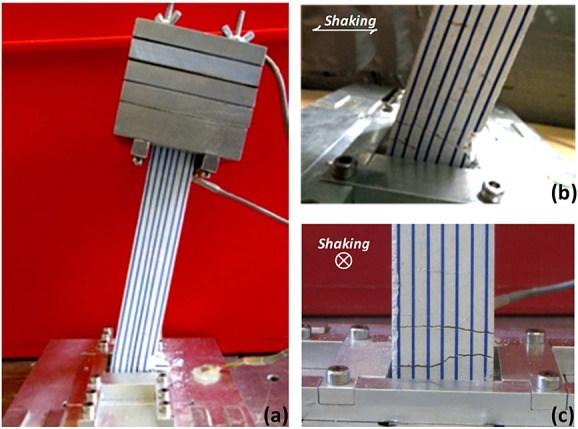
Photos of the conventional pier after Test 6 indicating the damage induced by shaking with Earthquake Scenario B followed by one additional very strong motion (the Takatori record): (a) view of the entire pier model (b) in-plane and (c) out-of-plane views of the column–foundation joint.